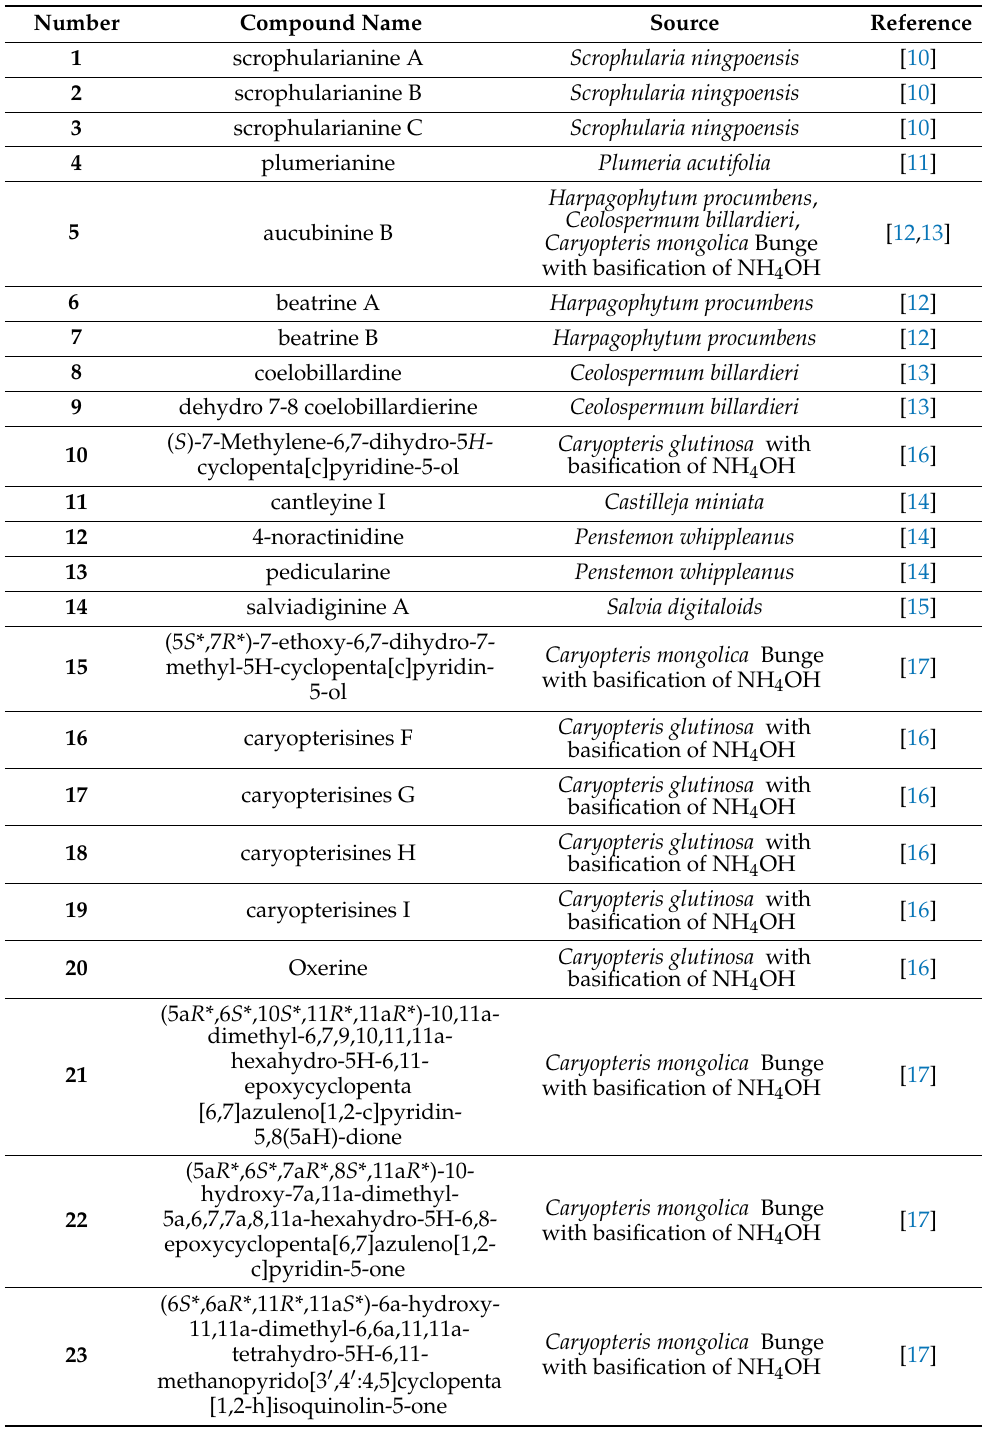
Table 1. Pyridine alkaloids derived from 4-demethyliridoids (Type